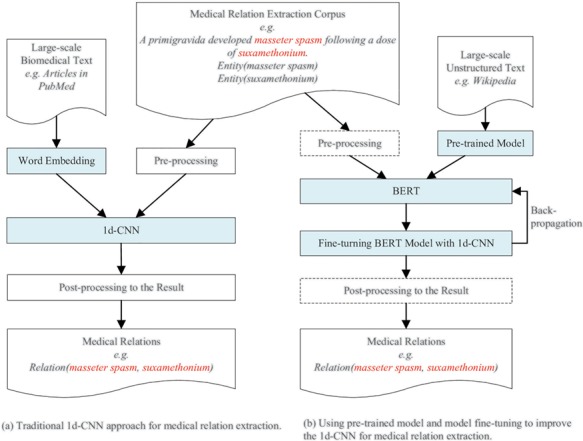
The architecture of the traditional approach and our proposed approach.